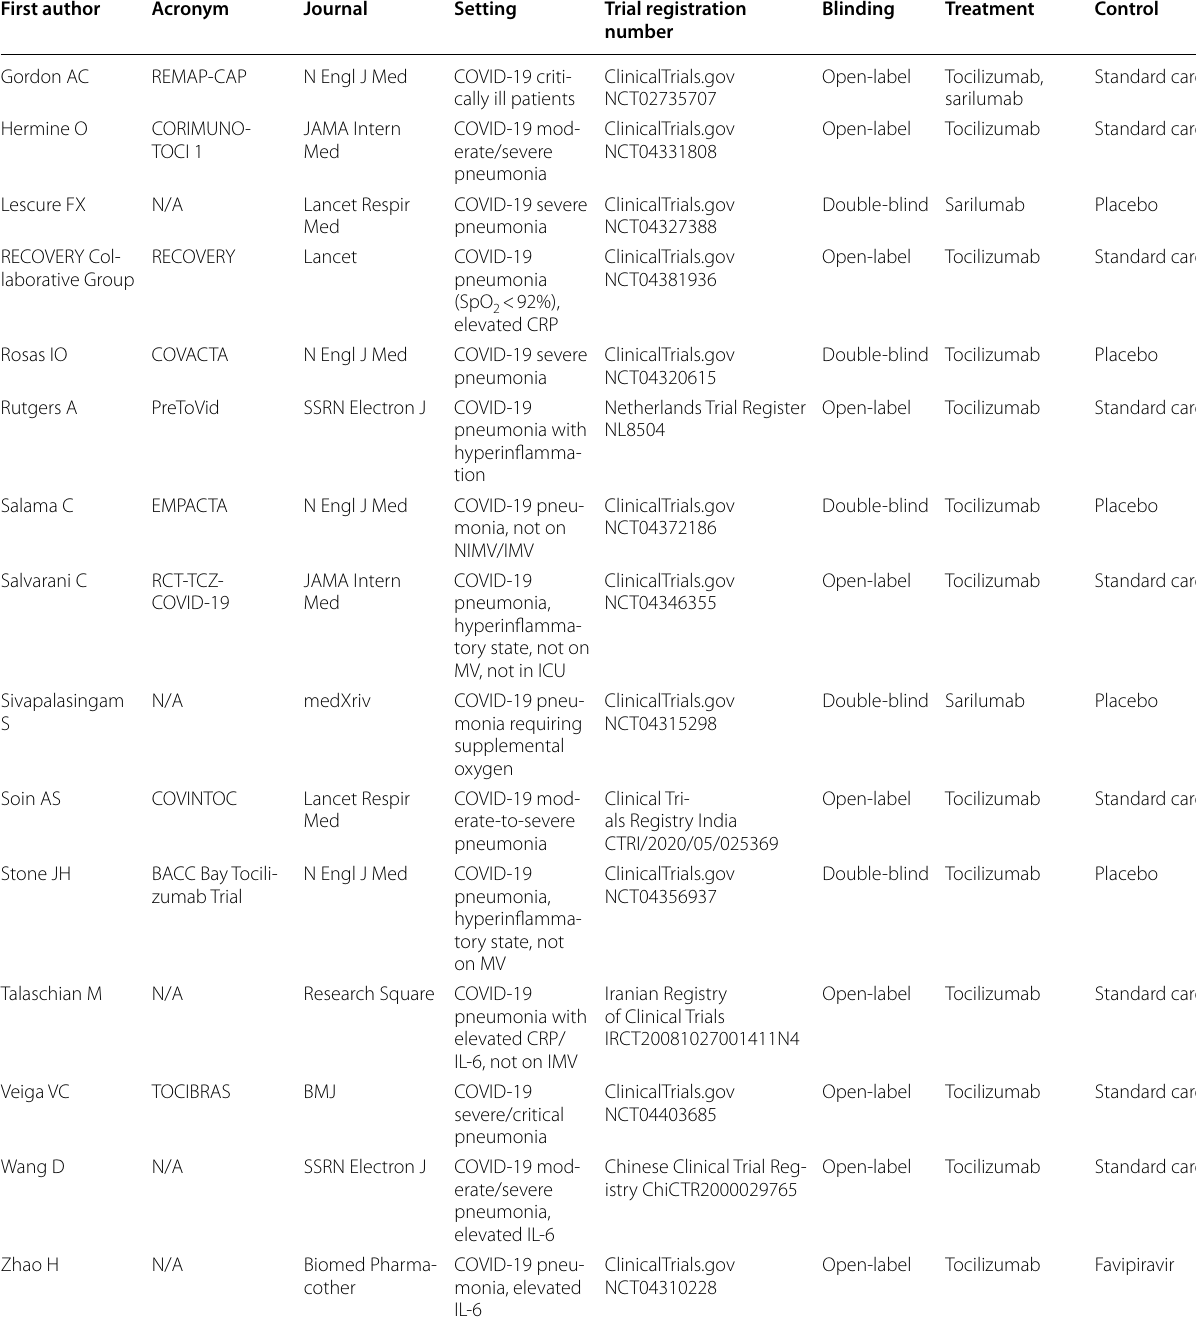
COVID-19: coronavirus disease 2019; CRP: C-reactive protein; IL-6: interleukin-6; IMV: invasive mechanical ventilation; MV: mechanical ventilation; N/A: not available; NIMV: non-invasive mechanical ventilation; SpO 2 : peripheral oxygen